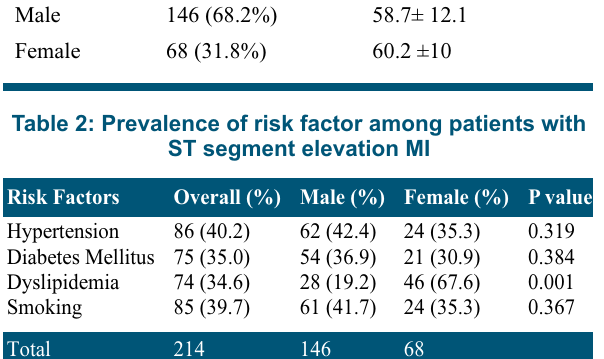
Table 3: Treatment choices and outcome of patients with ST-segment elevation MI